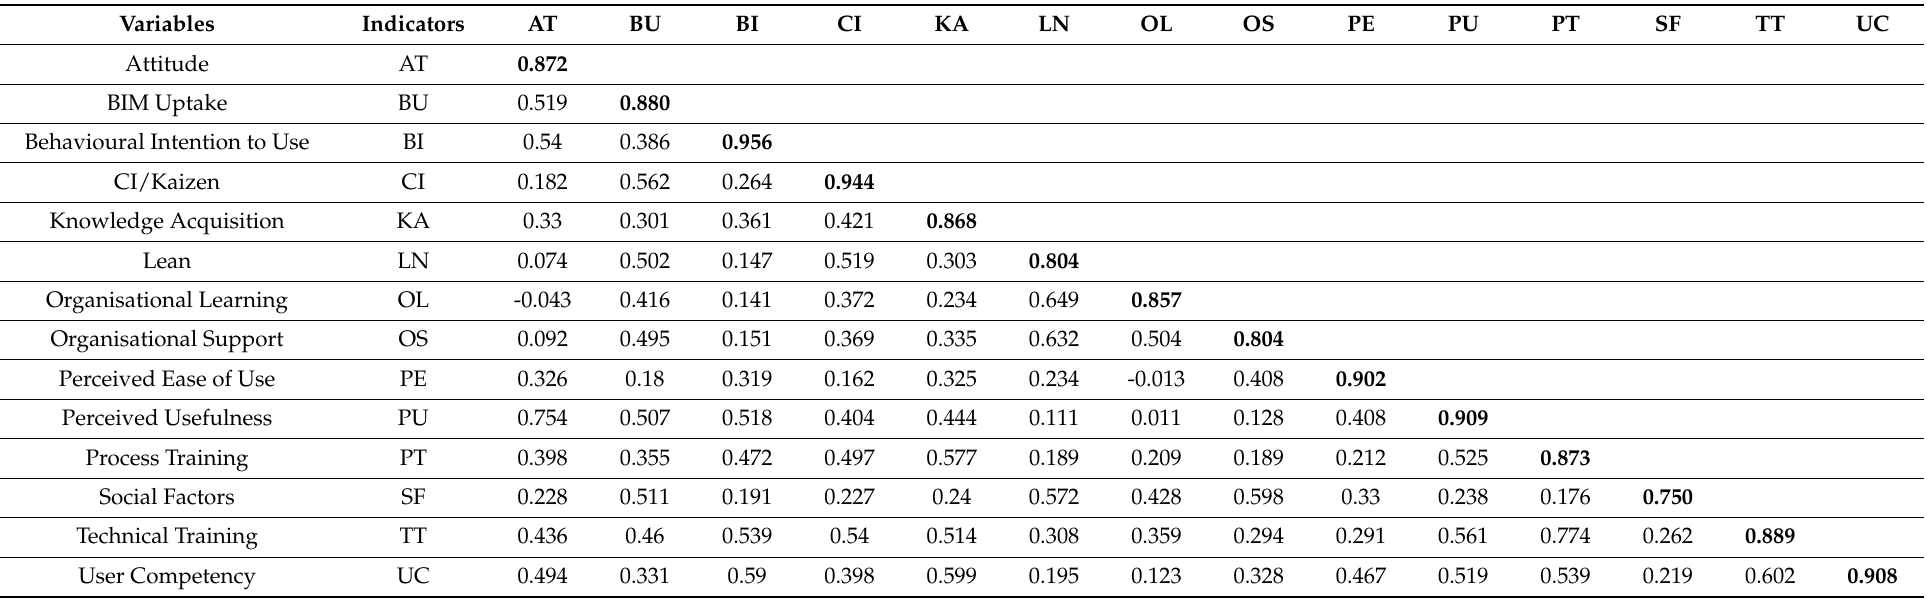
Table 5. Fornell-Larker